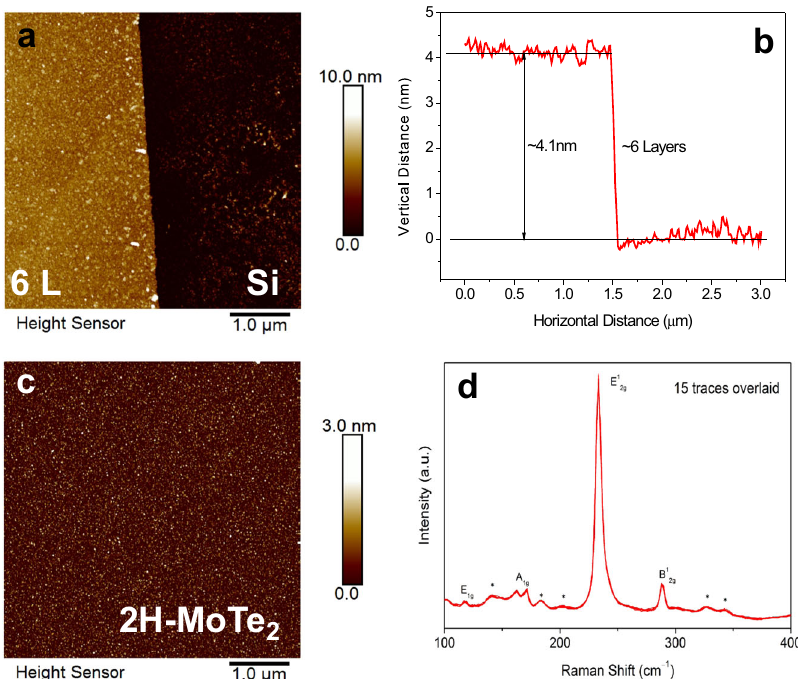
Fig. 2 Surface characterisation of 2H-MoTe 2 fi lms. AFM measurement over the 5 μ m × 5 μ m area and a representative 2D topographic pro fi le of the interface between few-layered 2H-MoTe 2 and SiO 2 /Si substrate ( a ); the variation in height between the fi lm and the substrate measured on a six-layered MoTe 2 fi lm from Fig. 2a ( b ); 2D topographic pro fi le of a 5 μ m × 5 μ m area from a few-layered MoTe 2 fi lm on SiO 2 /Si substrate ( c ); 532 nm Raman spectrum from a typical six-layered 2H-MoTe 2 on 300 nm SiO 2 /Si ( d